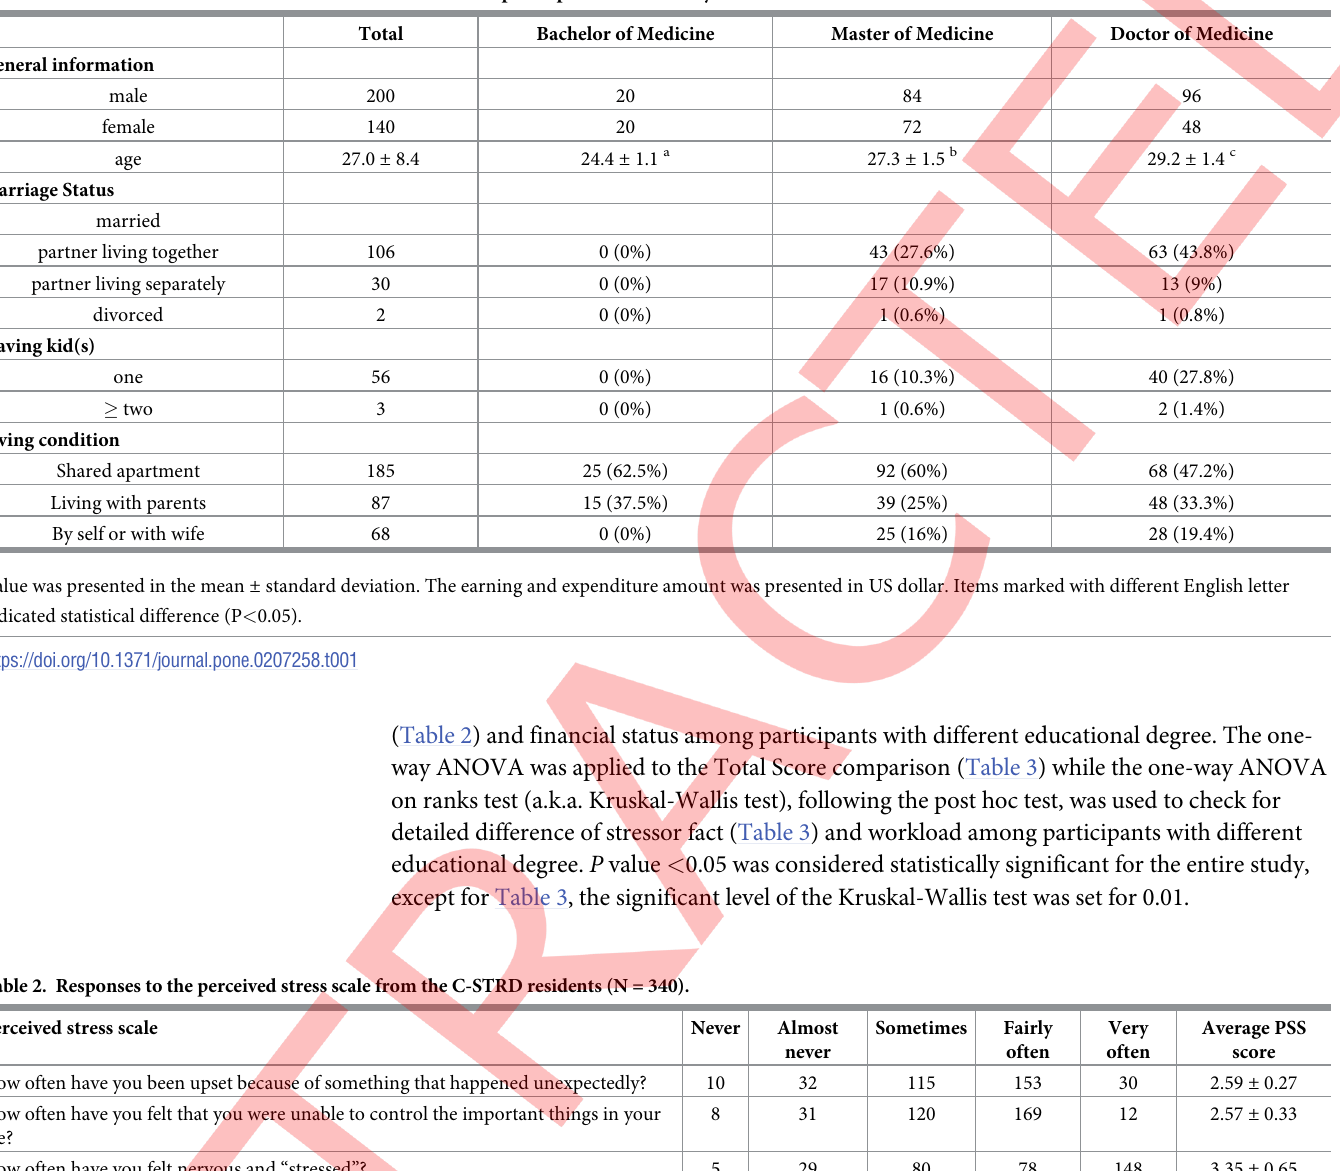
Table 1. General information of all the C-STRD residents who participated in the survey.